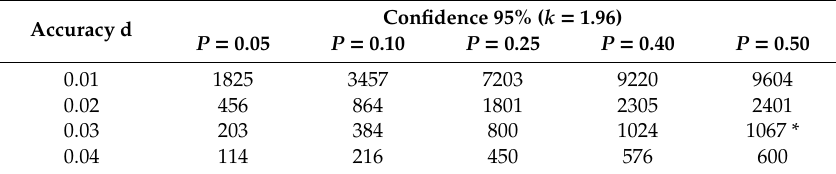
Table 4. Confidence levels for calculating the sample size of a